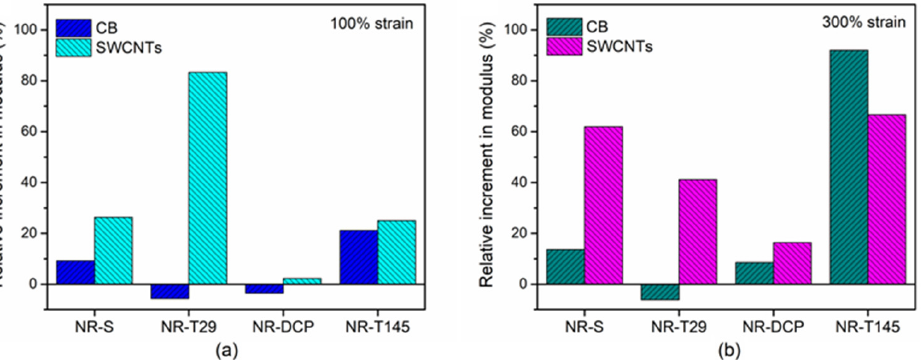
Figure 6. Relative increments in modulus at ( a ) 100 and ( b ) 300% strain for the NR composites vulcanized with different cross-linking agents and incorporating CB or SWCNTs as fillers.